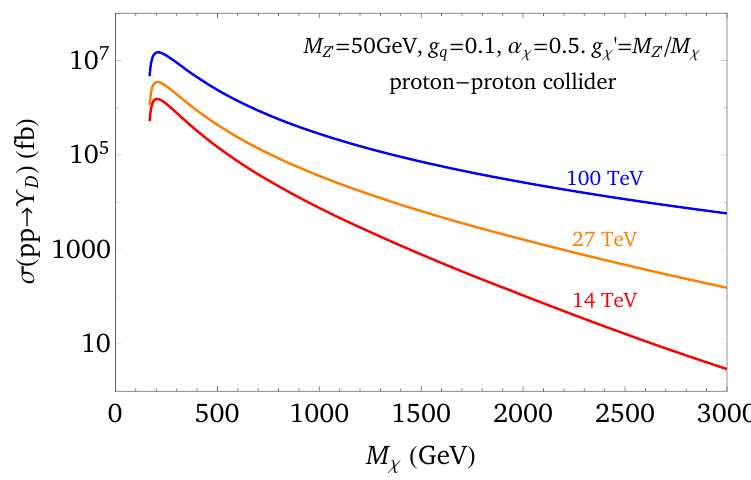
Figure 4 . Production cross section of (cid:7) D at the LHC as a function of the dark matter mass M (cid:31) . where N is the number quark (cid:13)avors that (cid:7) can decay into, and (cid:9)(0) is given in eq. (2.9). D f The calculation of non-relativistic bound state decay is reviewed in [66]. The (cid:12)rst decay channel is simply the inverse process of the Feynman diagram in (cid:12)gure 3 (left). The second decay channel (cid:7) ! Z 0 Z 0 is possible only in the presence of nonzero g 0 coupling, which D (cid:31) violates the charge-conjugation ( C ) parity. The Feynman diagram for this process is shown in (cid:12)gure 3 (right). The e(cid:11)ective operator responsible for this decay channel is